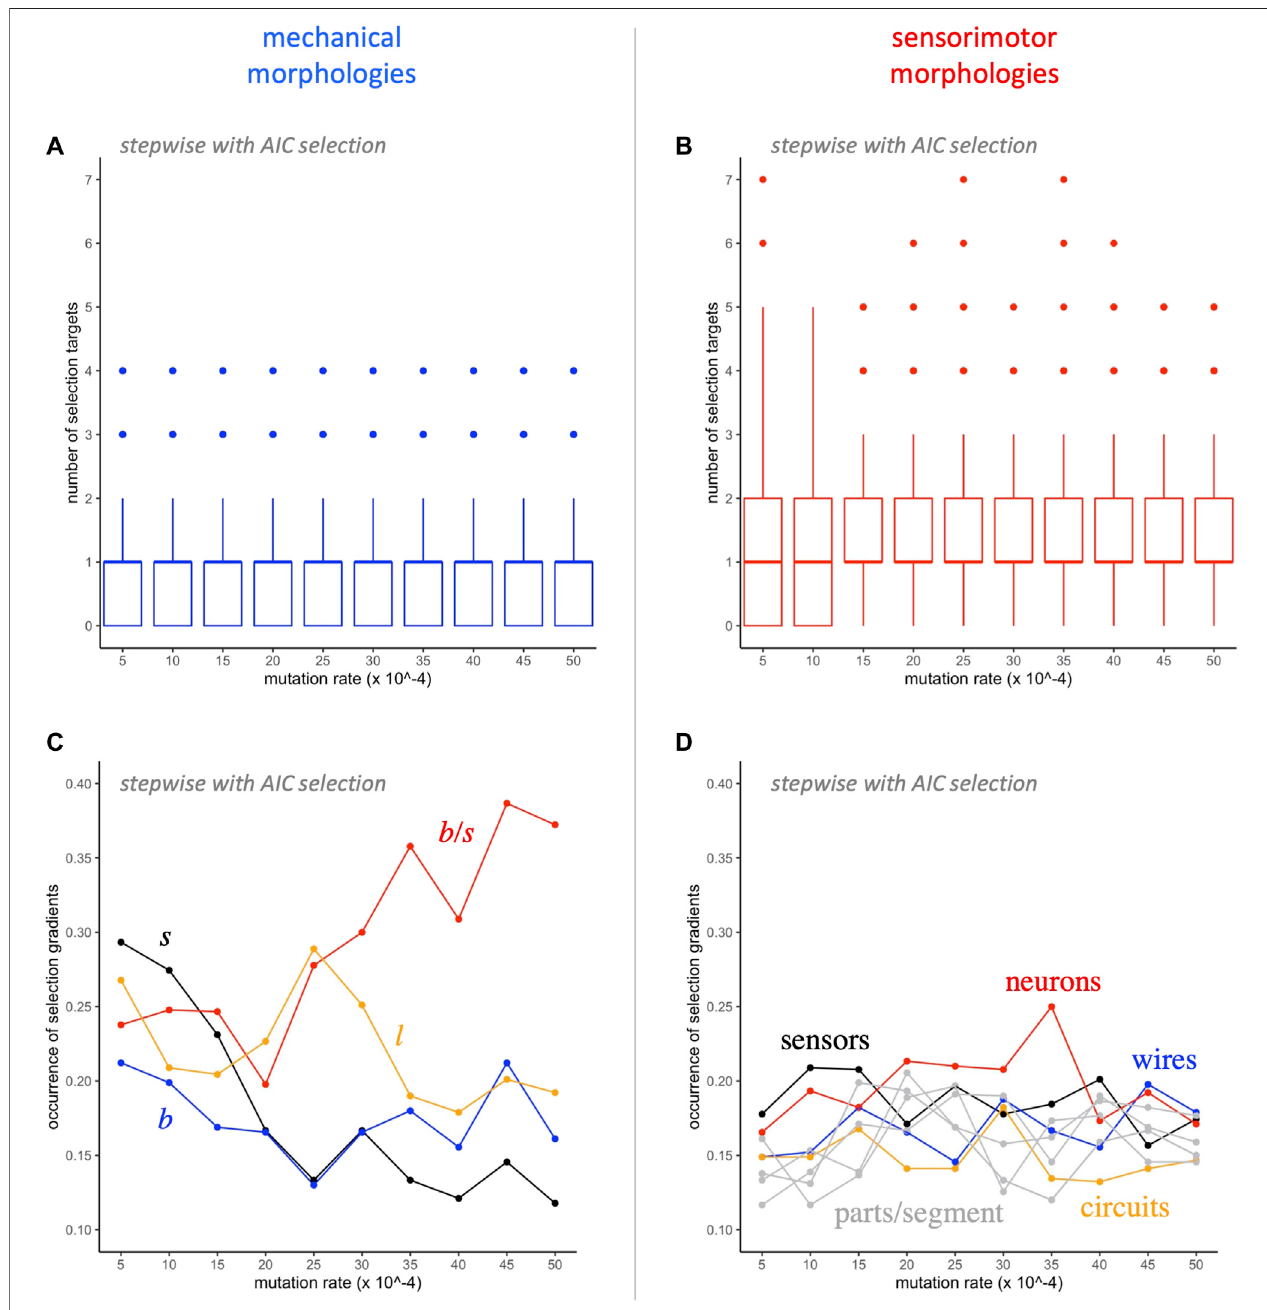
FIGURE 7 | Selection gradient analysis: switching morphological targets. A median of one mechanical (A) and one sensorimotor (B) morphology is targeted by selection at each level of mutation. The occurrence of the different mechanical morphological traits (C) diverges as the rate of mutation increases, with b nearly 40% while the occurrence of the other traits decreases. This pattern is absent in the occurrence of the different sensorimotor traits. Each mutation rate contains 900 models (A, B) , with a single point summarizing the rate of occurrence for a given trait (C, D) .